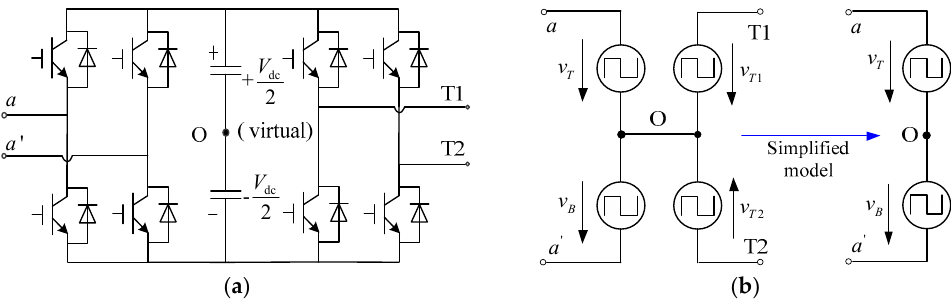
Figure 2. ( a ) The topology of a high-voltage power cells (HVPC); ( b ) Equivalent circuit model of HVPC for common mode voltage (CMV) analysis.